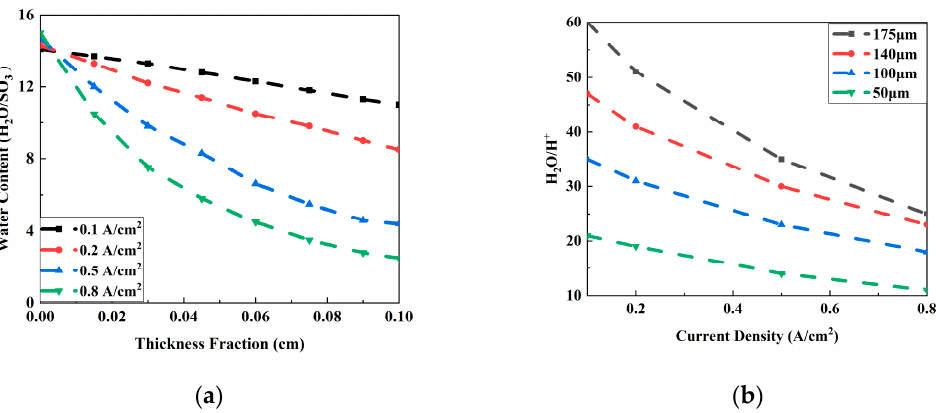
Figure 5. Water profiles in the FO membrane for four ampere densities when catholyte concentration is kept continuous at 35 g L − 1 NaCl. The positive electrode is on the left, whereas the net water flux moves from right to left ( a ). H 2 O/H + flux-specific value, β , vs. current density of four FO membrane thicknesses when the catholyte concentration is kept constant at 35 g L − 1 NaCl ( b ).